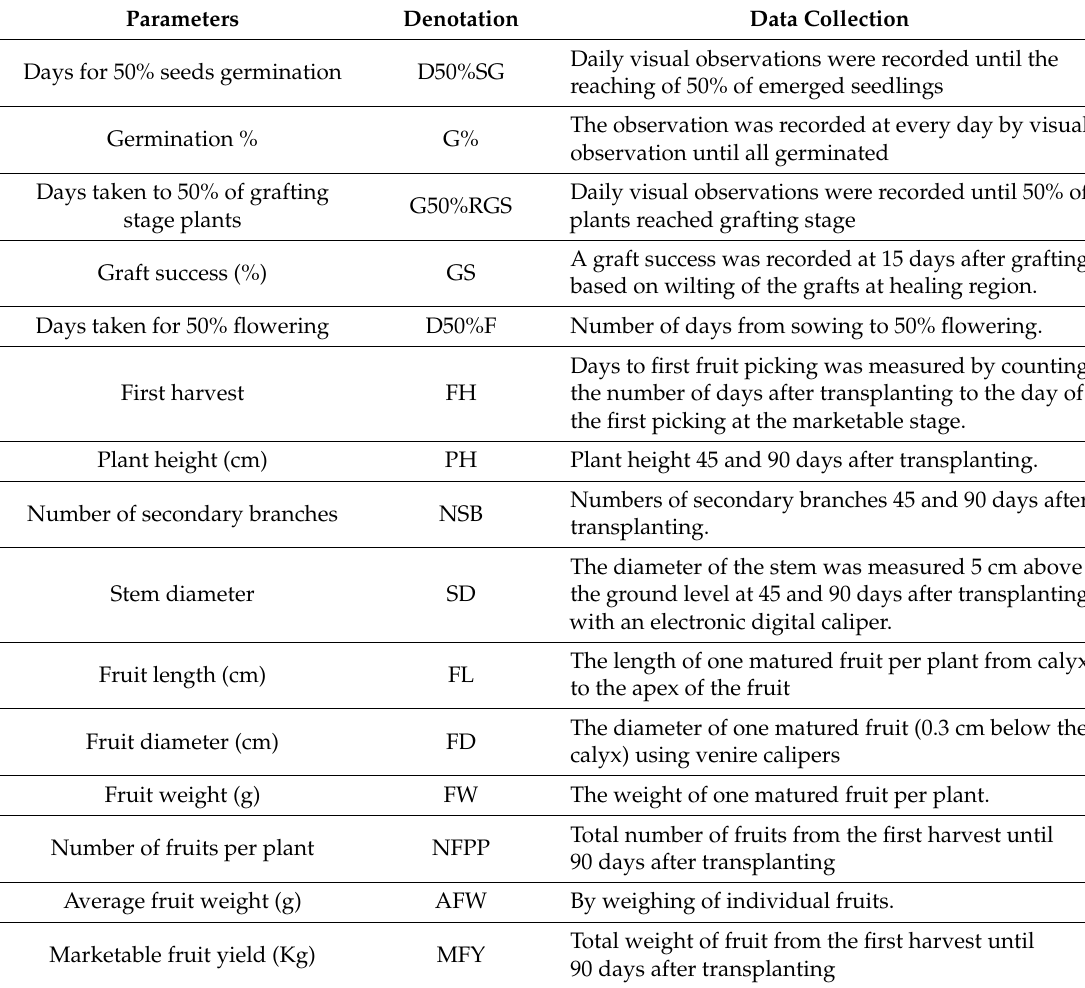
Table 6. Data and description in the nursery, and morphological